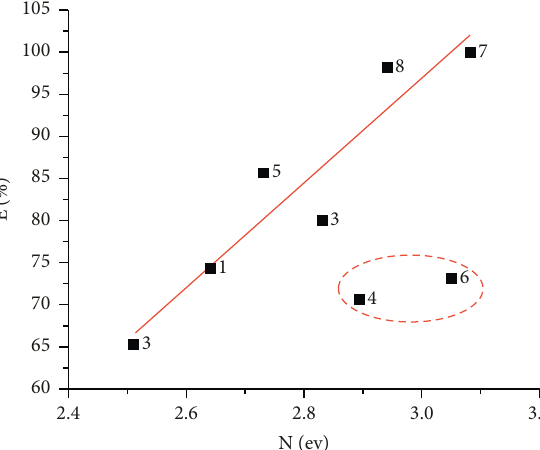
Figure 2: Correlation ( r � 0.94) between the calculated nucleophilicity (N) and the antioxidant efficiency